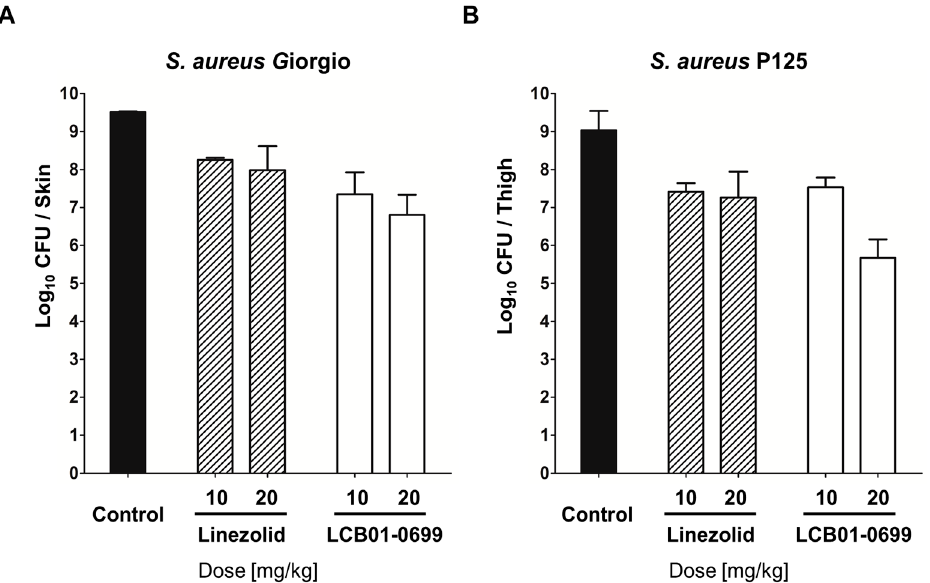
Figure 3. In vivo activities of LCB01-0699 and Linezolid against ( A ) S. aureus Giorgio (methicillin-susceptible S. aureus ) and ( B ) S. aureus P125 (methicillin-resistant S. aureus ) in mouse model of skin infection. Each bar represents mean ± SD. CFU: colony-forming units.